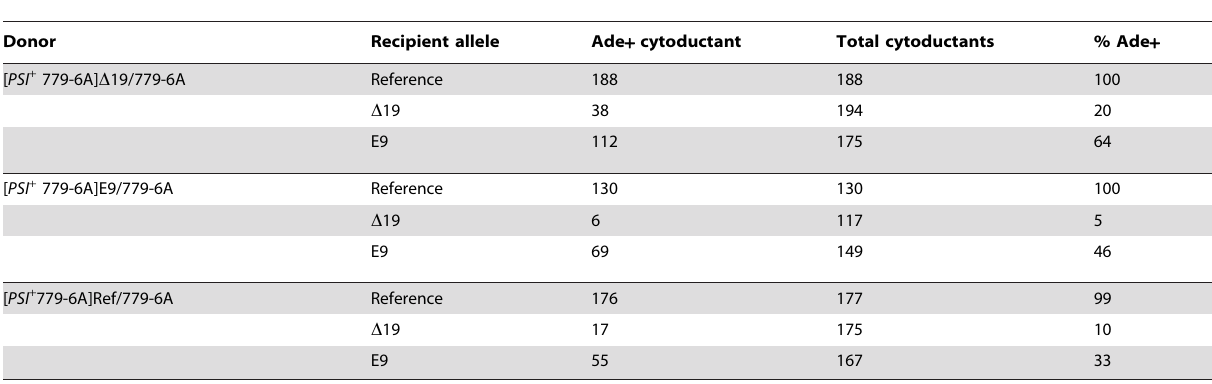
Table 4. Does passage through a Sup35 polymorph change [ PSI + ] transmission properties?